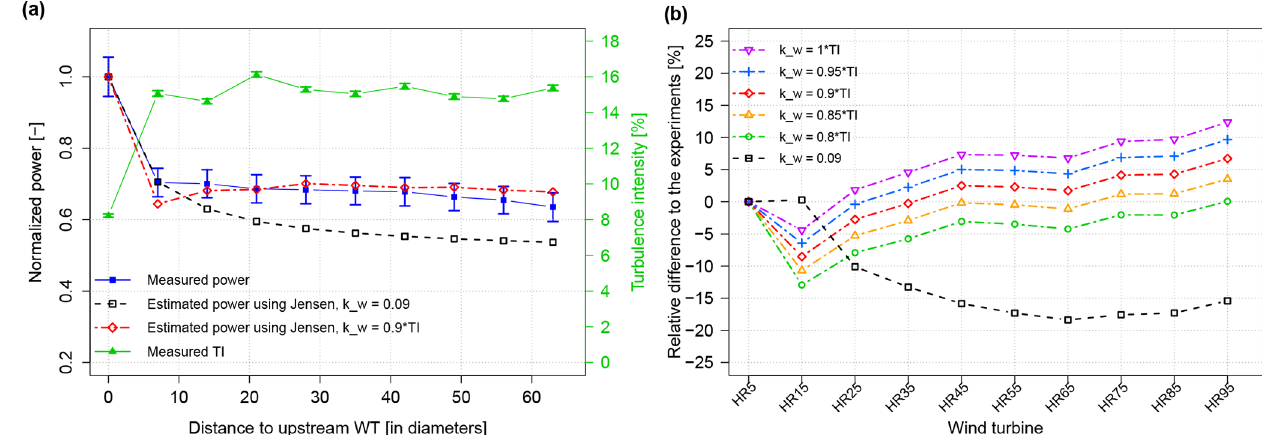
Figure 7. Comparison of the model performance at Horns Rev-I wind farm. Variation of experimental and modelled normalized power and turbulence intensity (measured by the nacelle anemometer) along the row (a) and variation of the error of the model at each wind turbine for various values of wake decay constants k w (b) . Error bars indicates the 68% normalized confidence